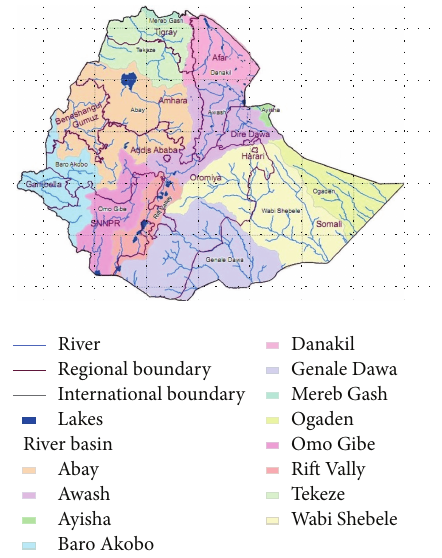
Figure 1: Location of major river basin in Ethiopia